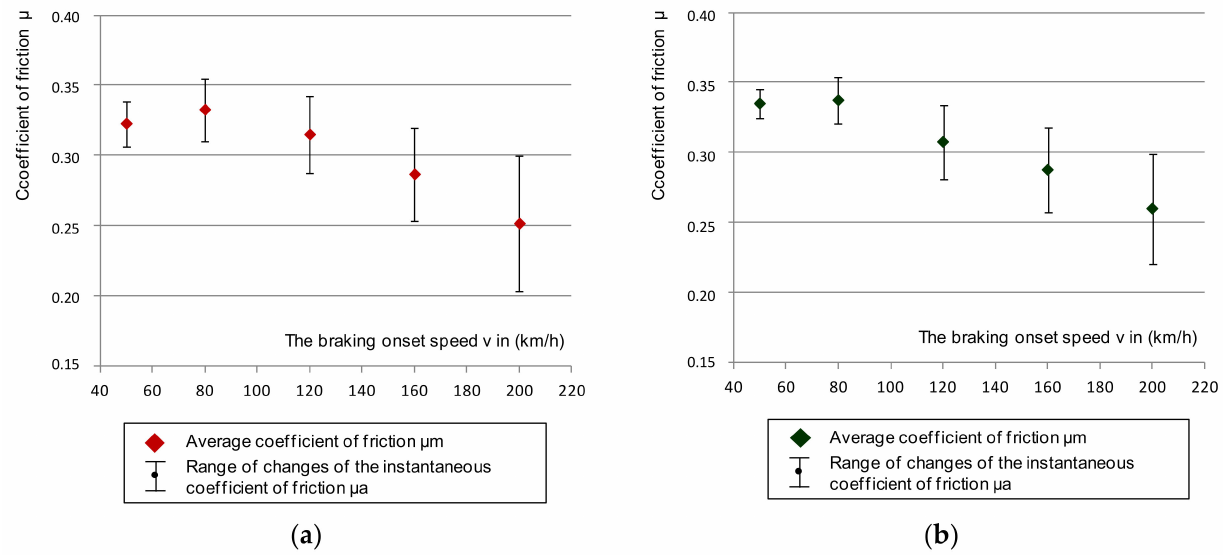
Figure 8. Characteristics of the friction coefficient (average and its spread) on the braking initiation speed with a pressure of 36 kN and mass per disc of 4.7 t: ( a ) for a classic disc, ( b ) for a disc perforated on the friction surface. Table 2. Friction coefficient